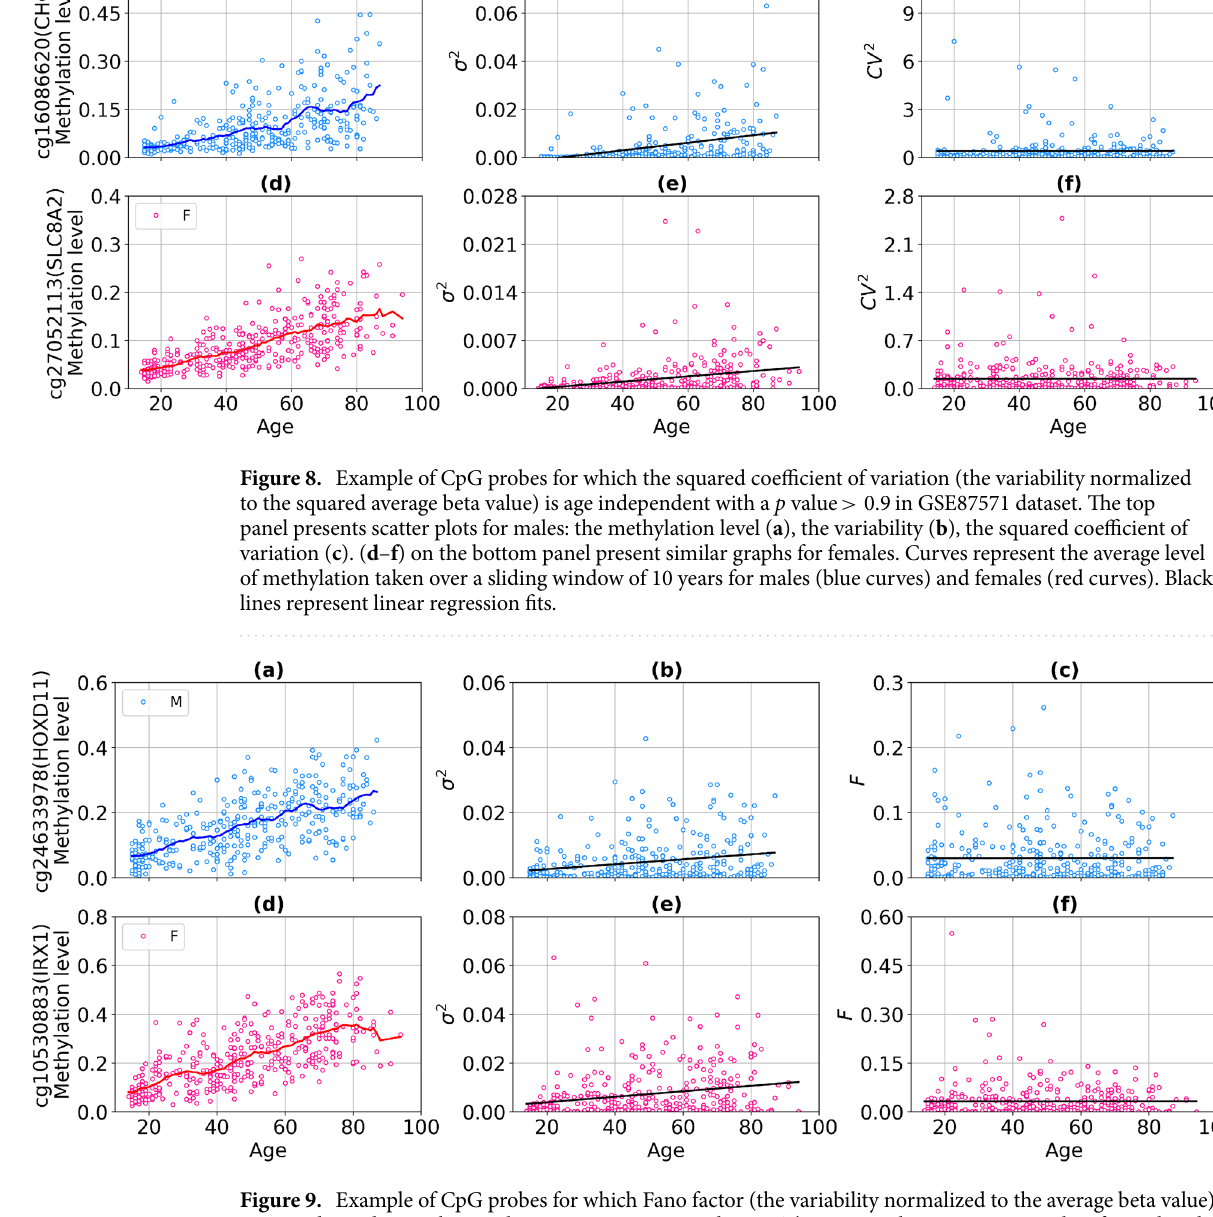
Figure 9. Example of CpG probes for which Fano factor (the variability normalized to the average beta value) is age independent with a p value > 0.9 in GSE87571 dataset. The top panel presents scatter plots for males: the methylation level ( a ), the variability ( b ), the Fano factor ( c ). ( d )–( f ) on the bottom panel present similar graphs for females. Curves represent the average level of methylation taken over a sliding window of 10 years for males (blue curves) and females (red curves). Black lines represent linear regression